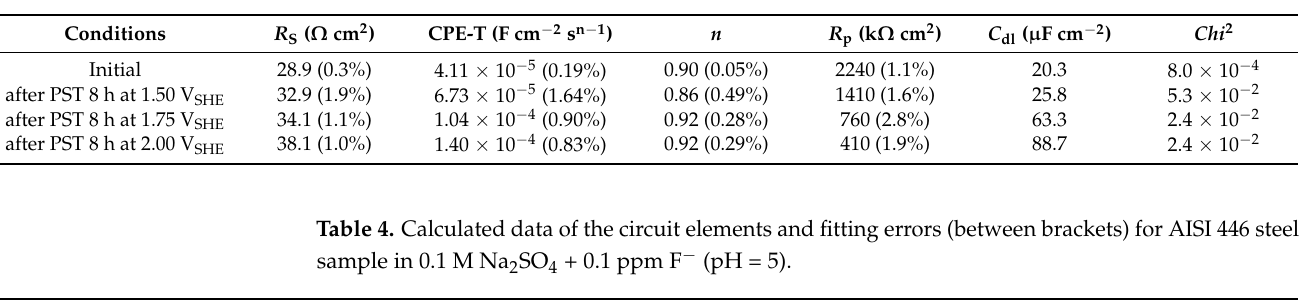
Table 3. Calculated data of the circuit elements and fitting errors (between brackets) for AISI 442 steel